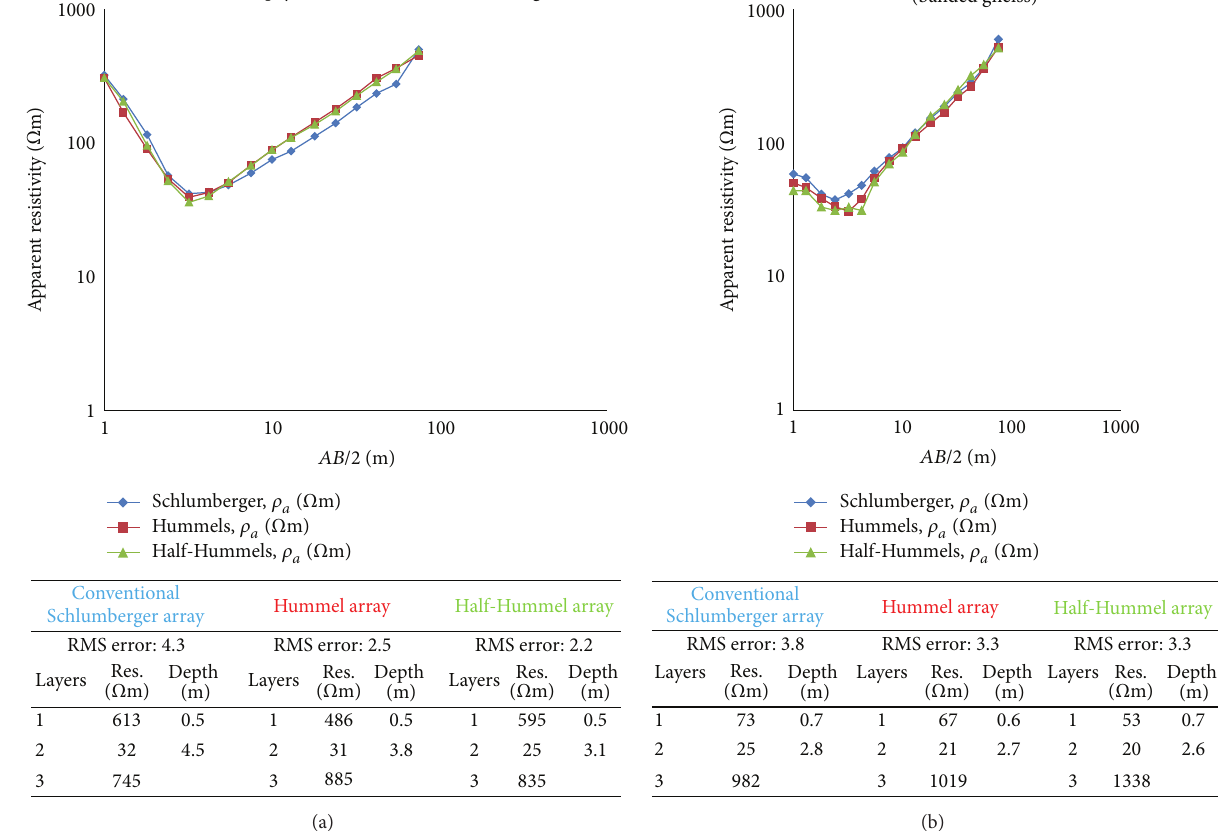
correlation ( 𝑅 ) for the Hummel/conventional Schlumberger and Half-Hummel/conventional Schlumberger arrays rang- ing between 0.98 and